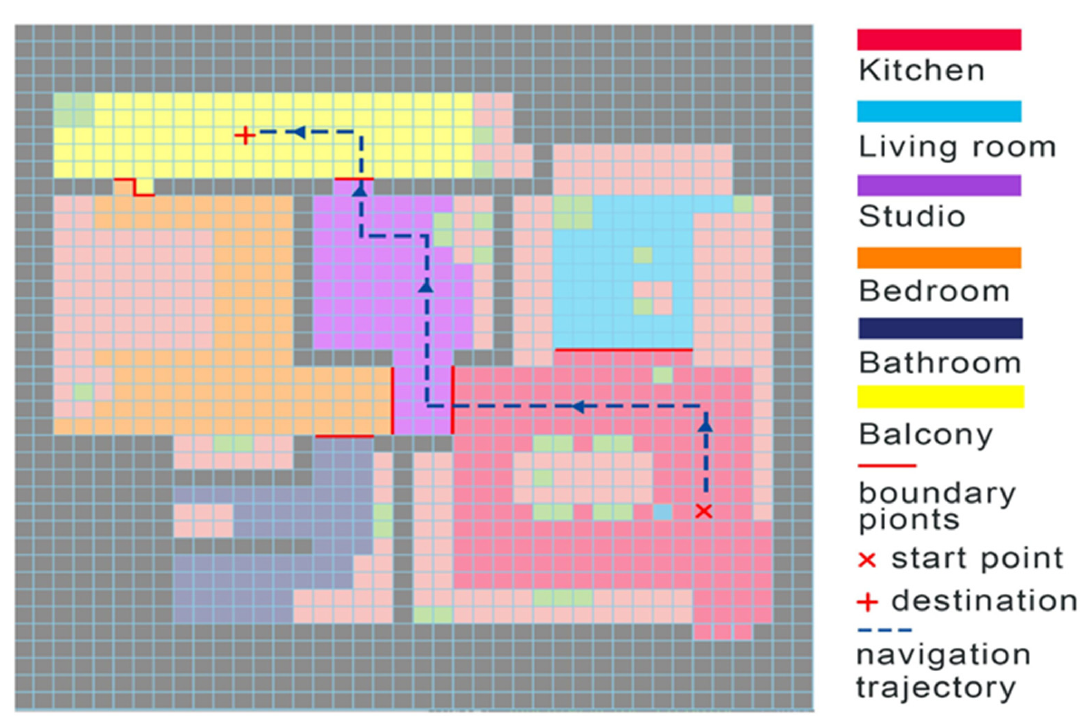
Figure 5. A navigation trajectory from kitchen to balcony.